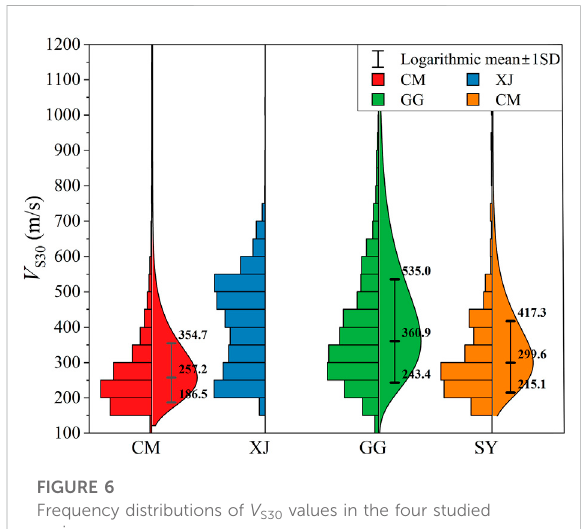
FIGURE 6 Frequency distributions of V S30 values in the four studied regions.